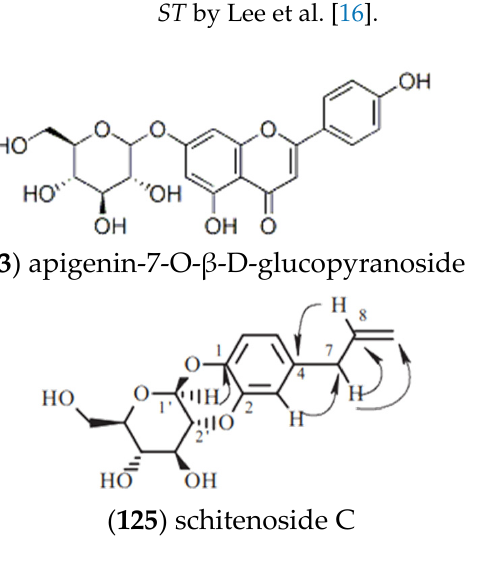
Figure 10. Structures of other compounds isolated from ST .